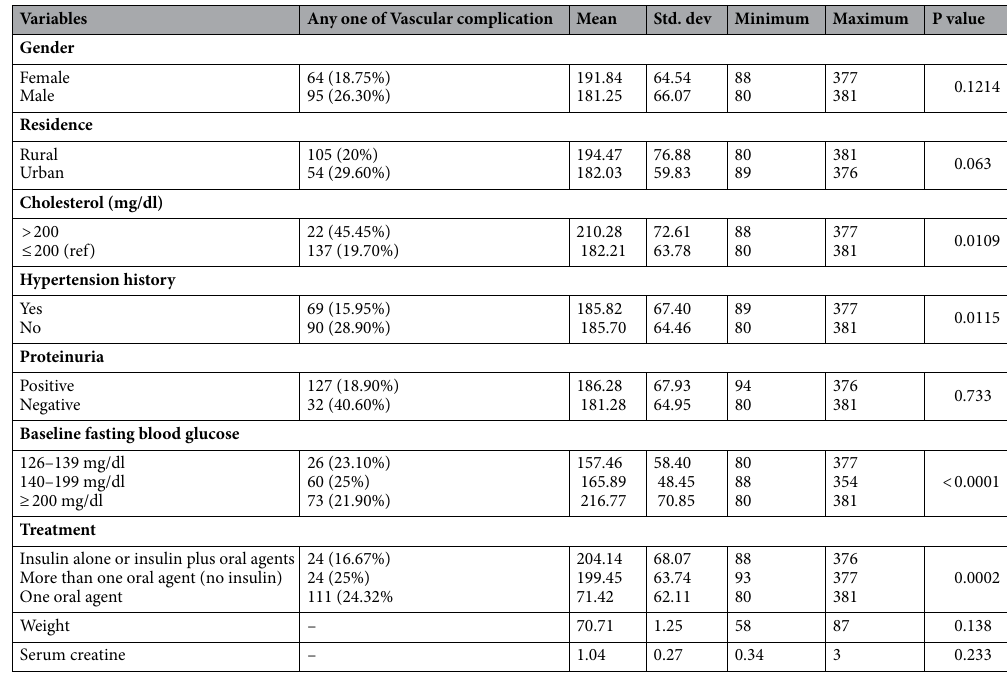
Table 3. Population characteristics and Univariate associations of factors with log of fasting blood glucose in FHRH, December 2011–March